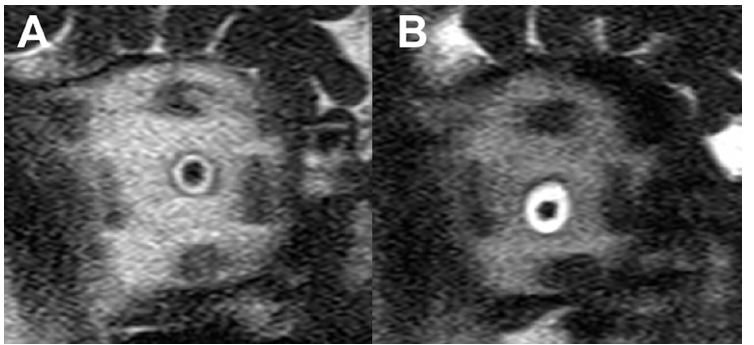
Fig 1. T2-weighted half-Fourier acquisition in single shot turbo spin-echo (HASTE) magnetic resonance imaging scans showing the cross-sectional area of the right intraorbital optic nerve (ION) 5 mm behind the eye. The cerebrospinal fluid can be identified as the hyperintense (bright) ring-shaped area in the center of the scan, and the ION parenchyma as the hypointense (dark) area within the hyperintense ring-shaped area. A , ION from a healthy individual; B , ION from a glaucoma